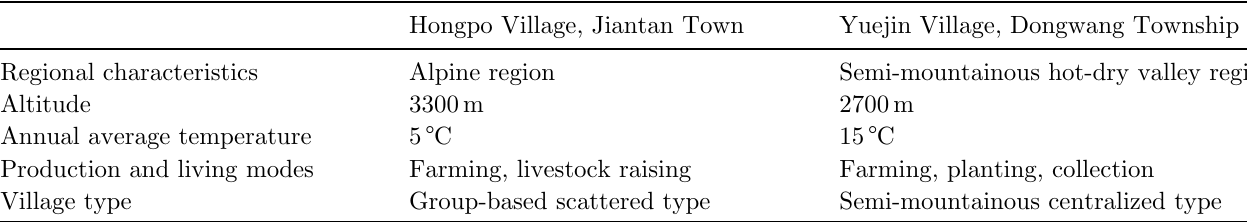
Table 1. Comparison between two villages in different